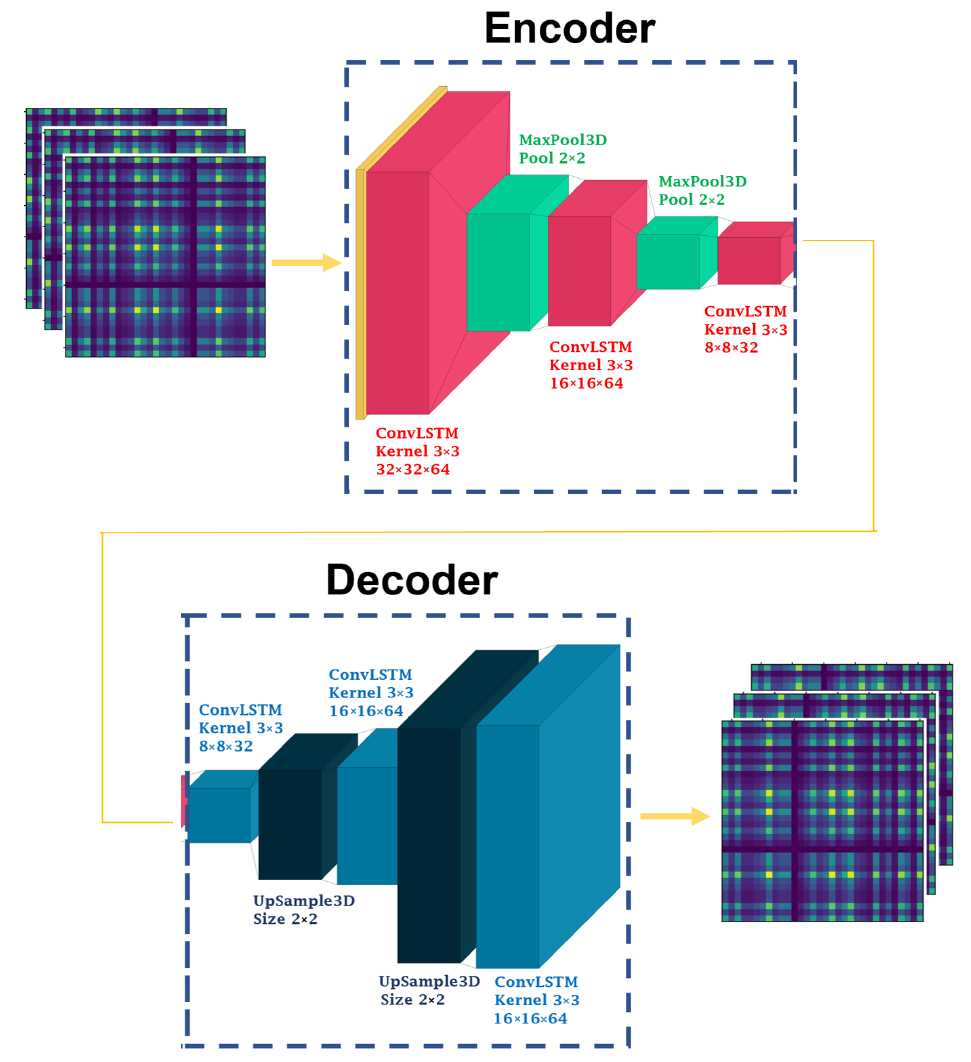
Figure 5. Proposed attention-based ConvLSTM autoencoder